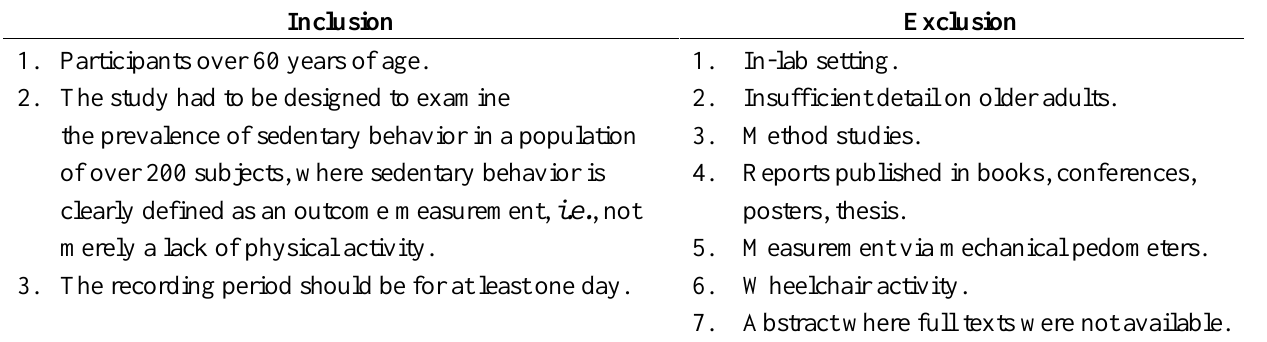
Table 1. Inclusion and exclusion criteria for systematic